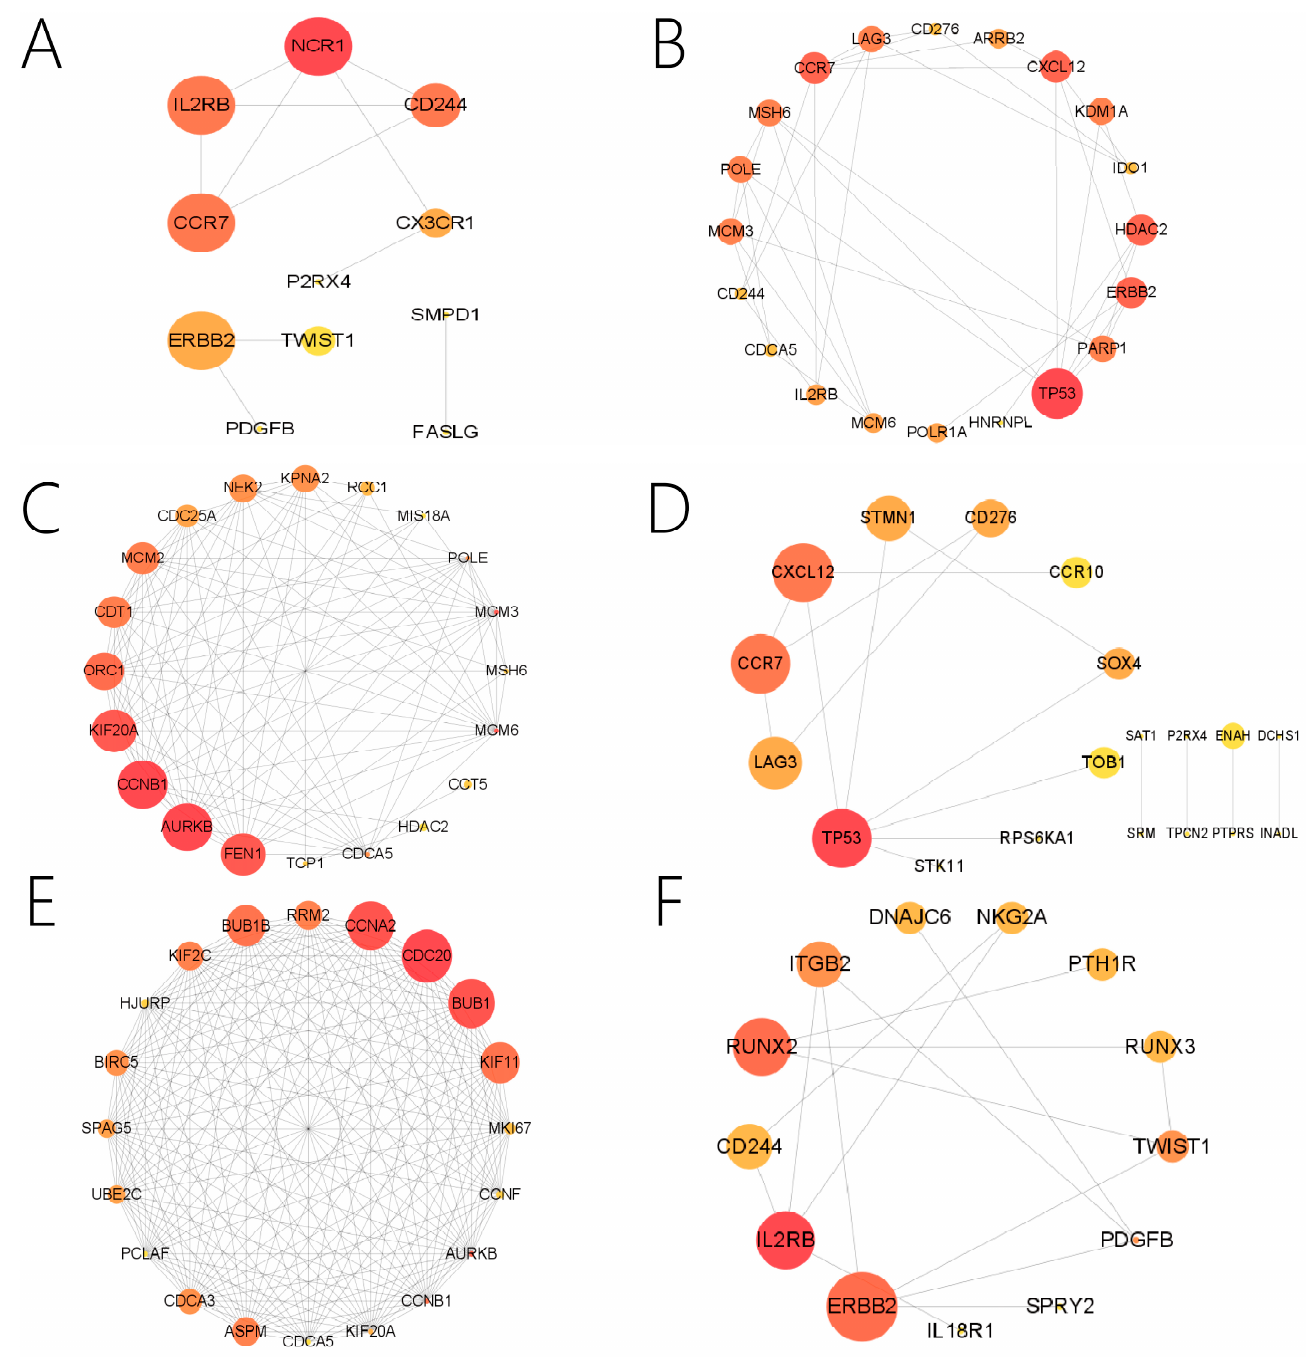
Figure 5. Visualization of potential genes in stage-specific modules. ( A ) PPI network for N-light cyan module. ( B ) PPI network for N-midnight blue module. ( C ) PPI network for N-light green module. ( D ) PPI network for N-grey module. ( E ) PPI network for M-light green module. ( F ) PPI network for M-light cyan module.